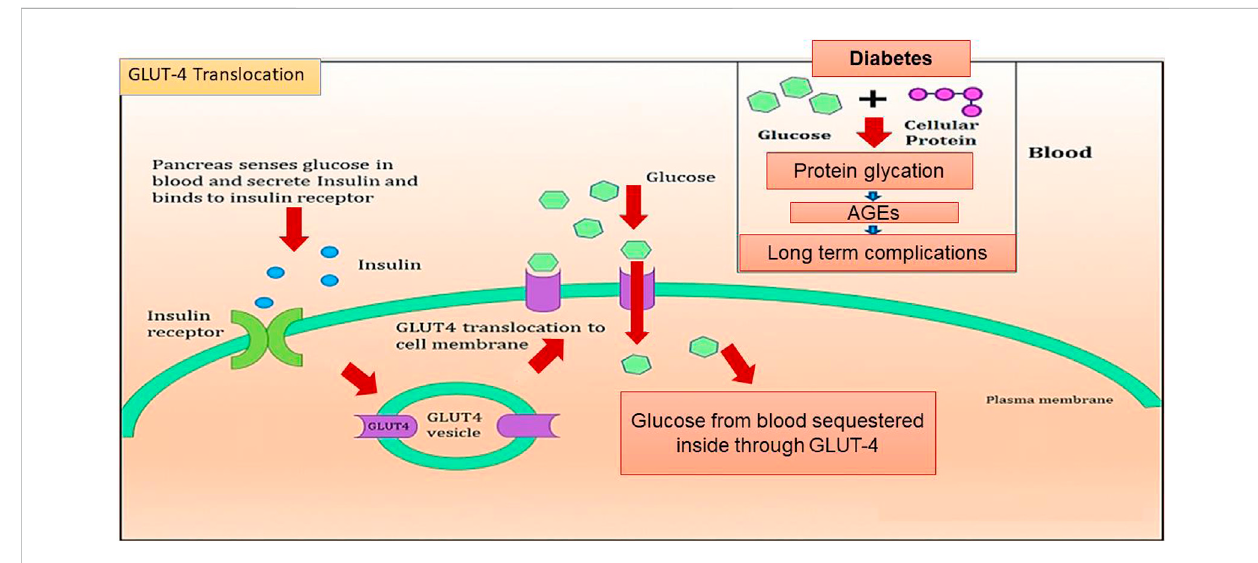
FIGURE 1 Graphical representation of GLUT4 translocation and AGE production in the